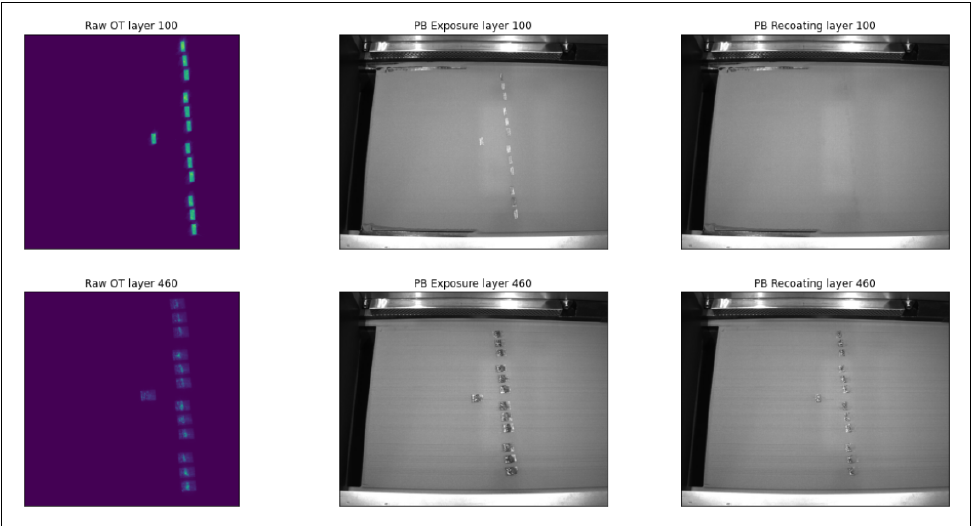
Figure 4. Raw OT image, PB image after laser exposure and PB image after re-coating. Layer 100 was printed normally while layer 460 shows surface deformation. The OT image shows bright spots on the printed portion of layer 100 in the top left corner of the image. After re-coating in the top right corner, the powder in the powder-bed image entirely covered the previous layer. On the other hand, the OT picture of layer 460 in the bottom left corner shows cold (blue) spots, and the corresponding powder re-coater layer shows the previous layer. So, in general, cold blue spots on OT and a blurry appearance of 3D object slices on powder-bed pictures, especially after re-coating, are clear indications of surface deformation. Labelling the LPBF images is one of the most pivotal and challenging tasks. Correct labelling of images requires an in-depth understanding of how surface deformation occurs and how it appears on the images. Additionally, sensor data information is vital in assigning the correct tag to the images. Figure 5 shows bar1 at various stages (layers) during the printing process. The surface deformations were observed after layer 433 and increased gradually per the designed overhang geometry. The clear observation of